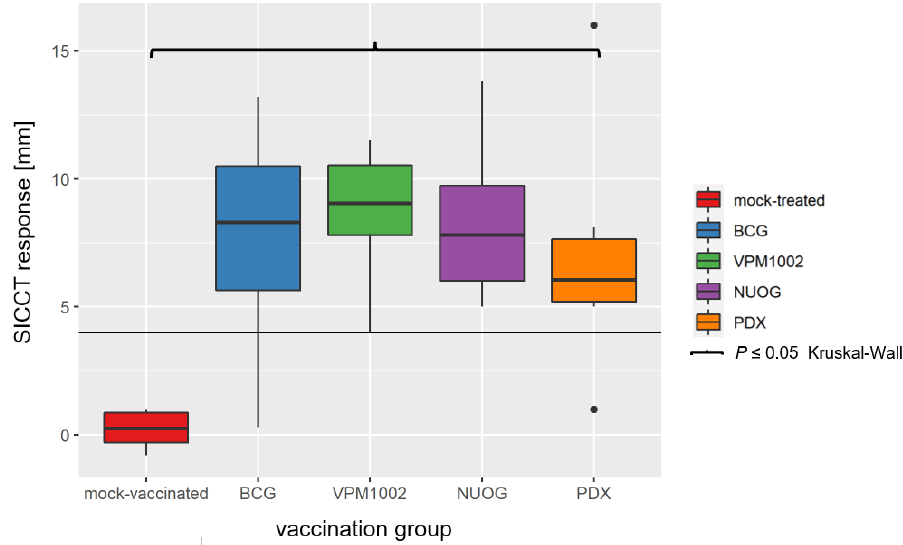
Figure 4. Results of the single intradermal comparative cervical test (SICCT) on 104 dpv of goats vaccinated with either BCG, VPM1002, NUOG, PDX, or mock-treated. Results show the change in the skin thickness after injection of bovine purified protein derivative (bPPD) minus the change in skin thickness after injection of avian PPD (aPPD; ∆ bPPD– ∆ aPPD). The horizontal line marks the limit for a positive test result (4 mm). All vaccinated groups statistically significantly differed from the mock-treated group.